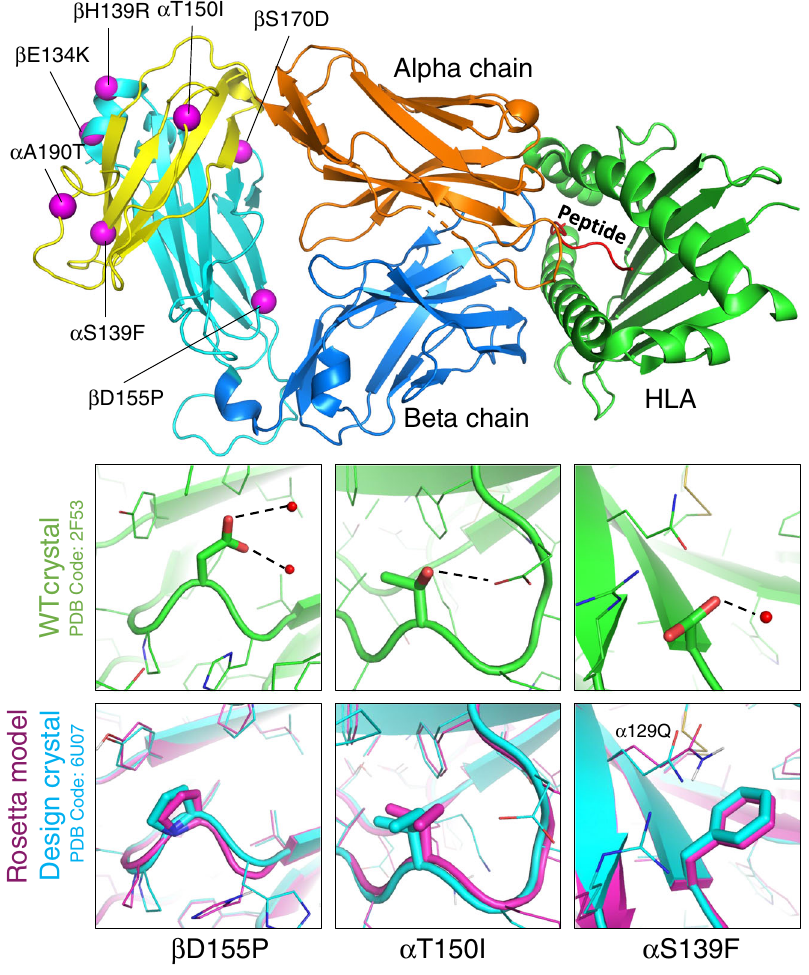
Fig. 2 Overview of seven mutations and structural characterization of mutations to nonpolar amino acids. (Top) here we show the location of each of the seven mutations with respect to the structure as a whole. The alpha chain is shown in orange and the beta chain is shown in blue, with the constant domains tinted a lighter hue on the left edge of the fi gure. (Bottom) three of the seven mutations were from polar side chains to hydrophobic side chains. Each column visualizes how the wild-type conformation has changed, showing the wild type in green (pdb: 2F53, energy minimized with Rosetta) and overlaying the Rosetta model (purple) with our crystal structure